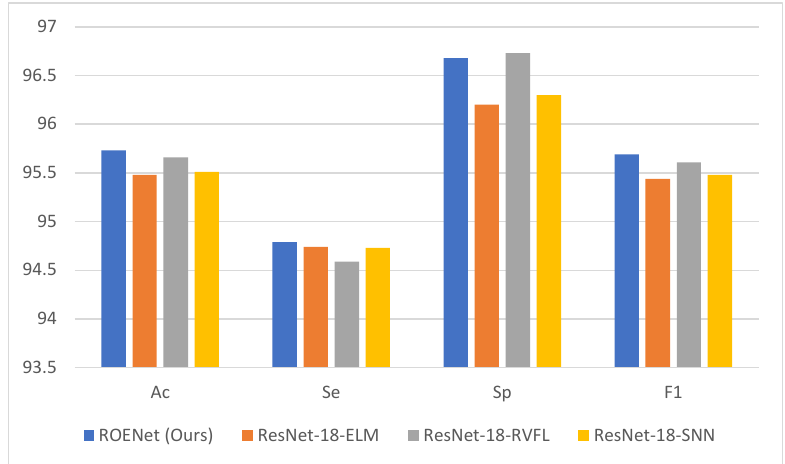
Figure 7. Effects of output ensemble.